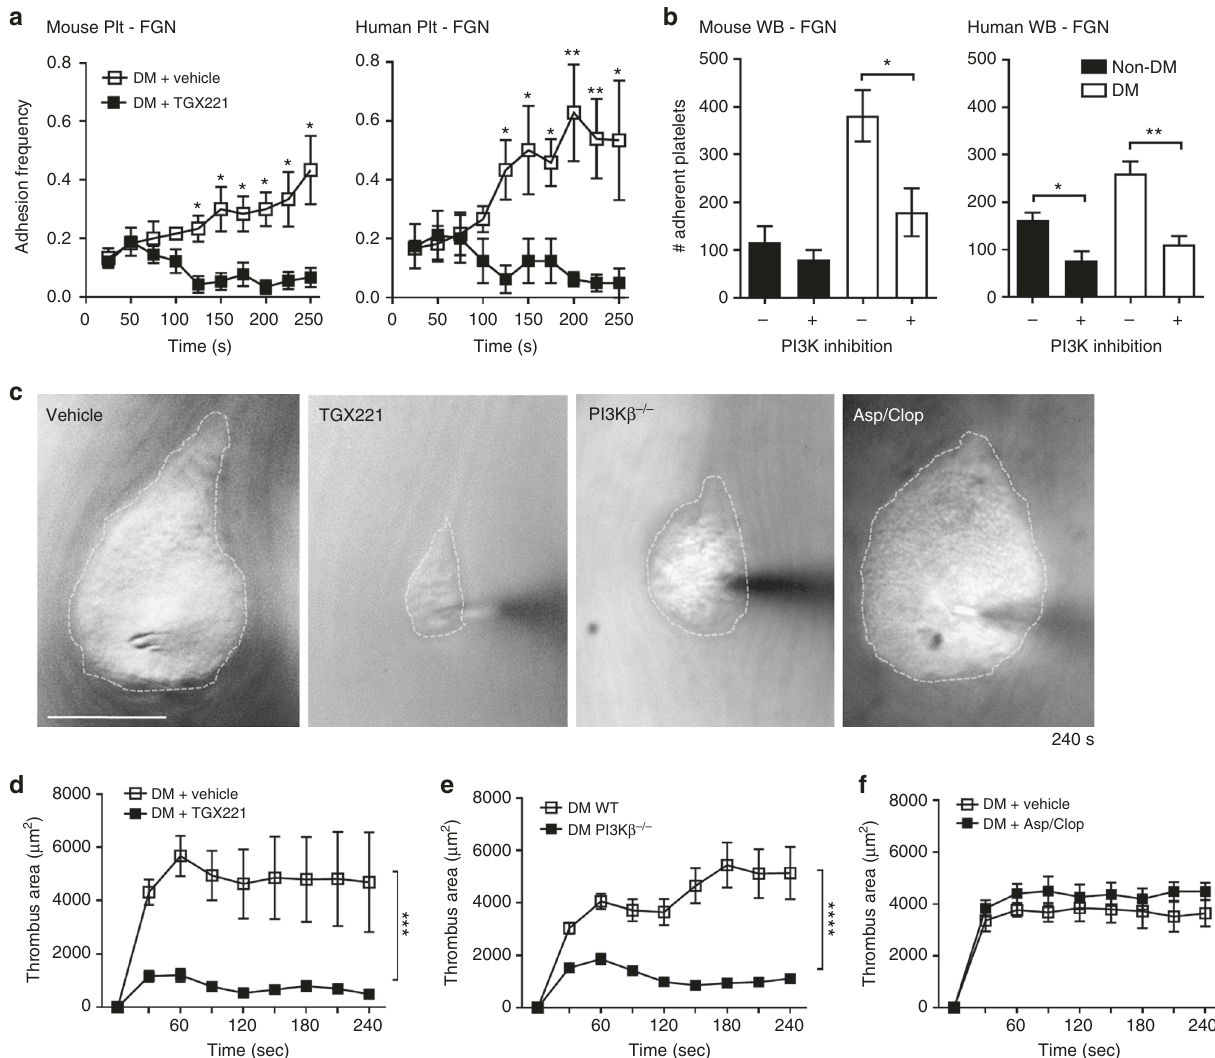
Fig. 7 PI3K β regulates integrin α IIb β 3 biomechanical signaling and adhesive function in diabetic platelets. a Washed platelets were isolated from non-DM and DM mice or humans, and treated with either DMSO (vehicle) or the PI3K β inhibitor TGX221 (TGX221, 0.5 µ M), then subjected to 100 BFP cycles using FGN-coated beads, as described in Fig. 6c – e. Adhesion frequency was analyzed for every 10 consecutive cycles and plotted over time (2.5 s/cycle). b Hirudinated whole blood from non-DM and DM mice or humans were treated with DMSO (vehicle) or the pan-isoform PI3K inhibitor LY294002 (100 μ M) for 10 min, perfused over FGN matrices at 600 or 300 s − 1 for mouse or human blood respectively, and the number of adherent platelets analyzed after 4 min perfusion. c – f Thrombi were induced using the needle in situ model in diabetic mice treated with DMSO (vehicle), or PI3K β inhibitor TGX221 (2.5 mg kg − 1 ), or aspirin/clopidogrel, and in diabetic PI3K β − / − mice. c Representative DIC images depict thrombi (broken outline) formed around the needle tip 240 s post needle insertion. Note that the enhanced thrombotic response observed in diabetic subjects was abrogated by PI3K β de fi ciency or inhibition, but not by aspirin/clopidogrel. d – f Thrombus surface area was quanti fi ed over the entire 4 min period for the indicated diabetic mouse types. Results are expressed as the mean ± s.e.m. of n = 3 mice, with 6 ( d ) or 8 ( e , f ) thrombi/mouse. Results were assessed by an unpaired, two-tailed Student ’ s t -test, where * p < 0.5; ** p < 0.01; *** p < 0.001; **** p < 0.0001; Scale bars = 50 μ